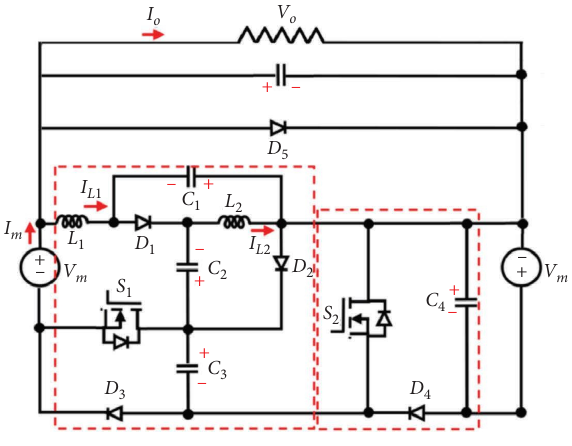
Figure 1: Dual input quasi Z source